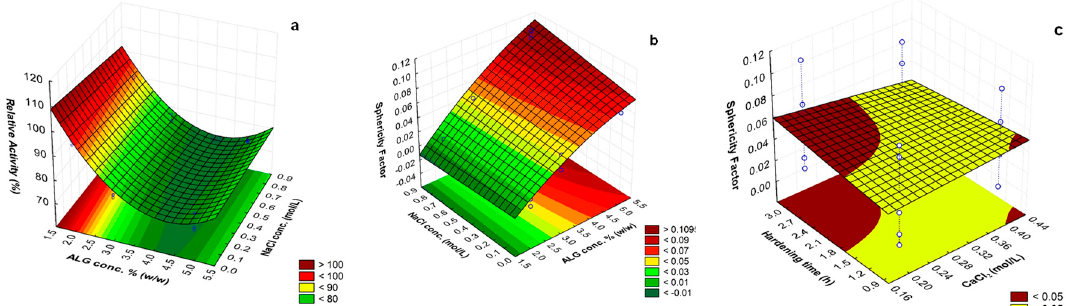
Figure 3. Response surface and contour plots of the combined effects of: concentration of ALG and NaCl on ( a ) the encapsulated cellulase relative activity and ( b ) the alginate particle sphericity factor (SF) when the other two factors c(CaCl 2 ) and hardening time (HT) were at center points; ( c ) concentration of CaCl 2 and HT on the alginate particle sphericity factor (SF) when the other two factors c(ALG) and c(NaCl) were at center points.